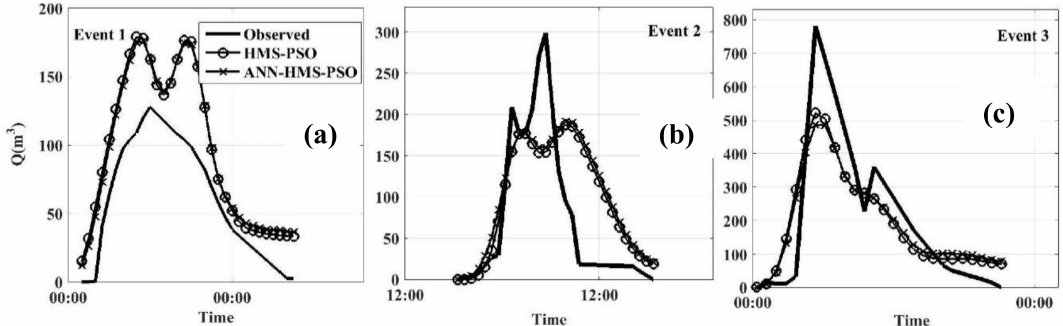
Figure 9. Observed and simulated discharge hydrographs for jointly event scenario (JEvent 1–3) occurred on ( a ) 19 September 2004; ( b ) 6 May 2005; and ( c ) 9 August 2005